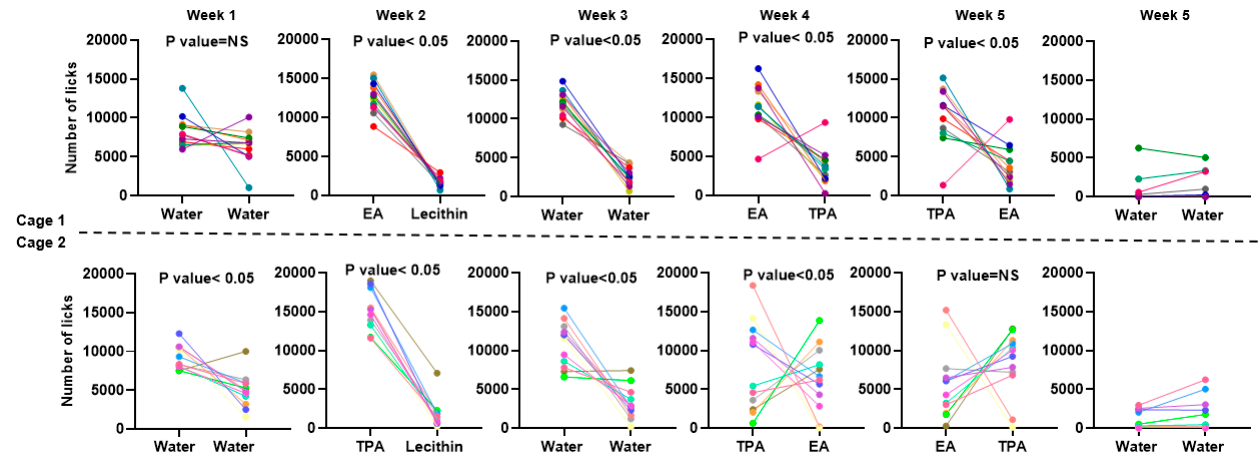
Figure 5. Weekly number of the licks and consumption of solutions in cage 1. Each box shows the number of the lick for 1 week; each point with a specific color represents an individual mouse. The differences between the lick numbers were evaluated by unpaired t-test.